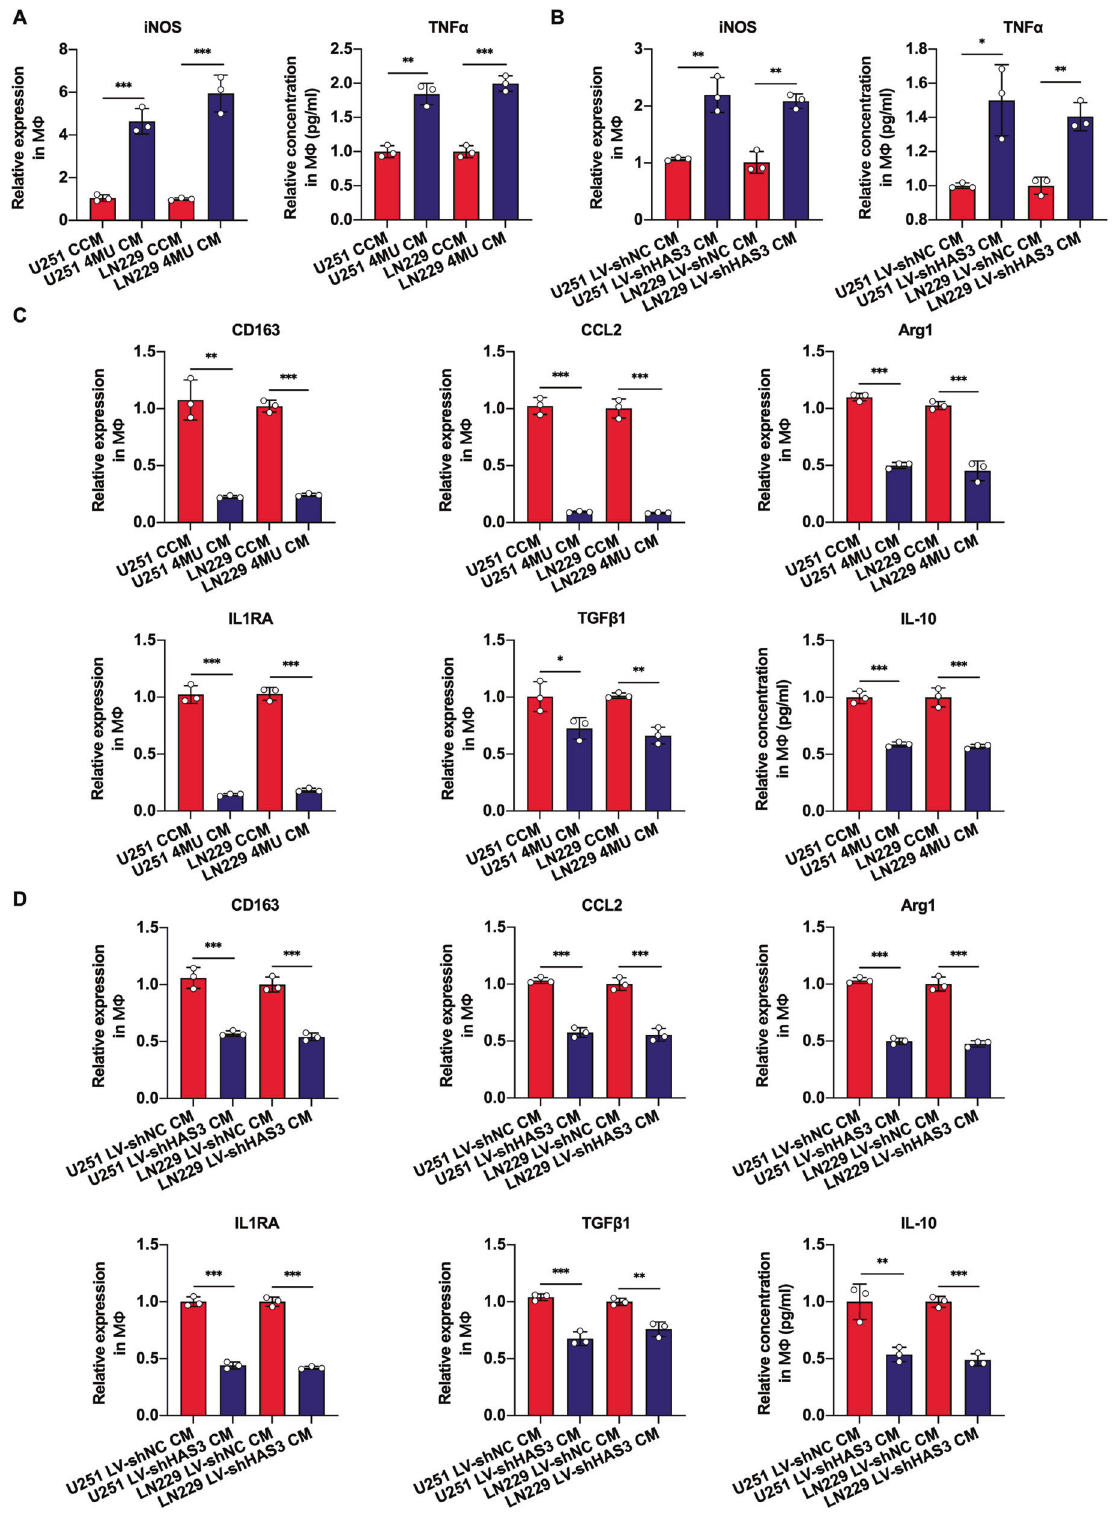
Fig. 1 Disruption of HA synthesis in glioblastoma by 4MU treatment or HAS3 knockdown modulates M1 macrophages polarization. A – D Macrophages were cultured with 4MU CM or LV-shHAS3 CM for 48 h. The relative mRNA expression levels of iNOS, CD163, CCL2, Arg1, IL1RA, and TGF β 1 in macrophages were detected by qRT-PCR. Induced macrophages were cultured alone in FBS-free medium for another 48 h, and the relative concentrations of TNF α and IL-10 secreted from the macrophages were detected by ELISA. Error bars show mean ± SD. * P < 0.05, ** P < 0.01, and *** P < 0.001.